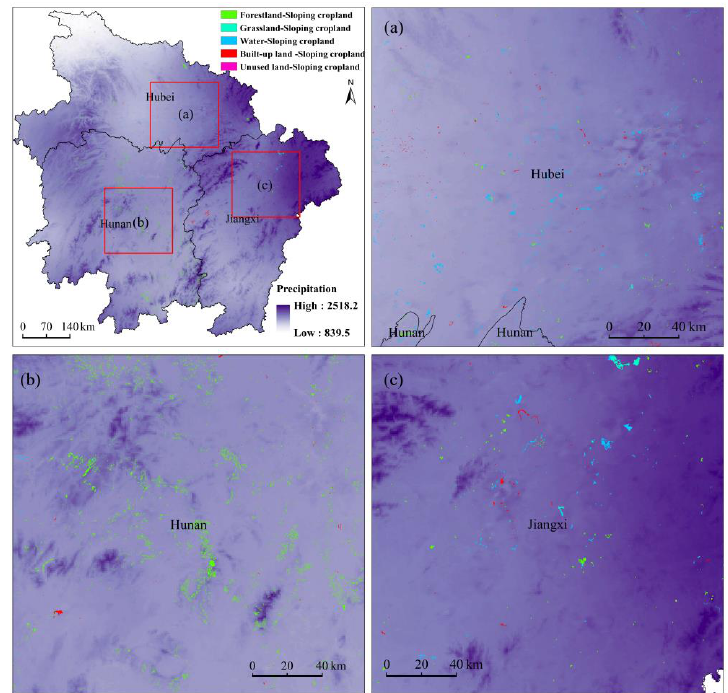
Figure 13. Spatial relationships between annual average precipitation and new sloping cropland in 2005–2010. ( a ) Selected typical region in Hubei Province. ( b ) Selected typical region in Hunan Province. ( c ) Selected typical region in Jiangxi Province.